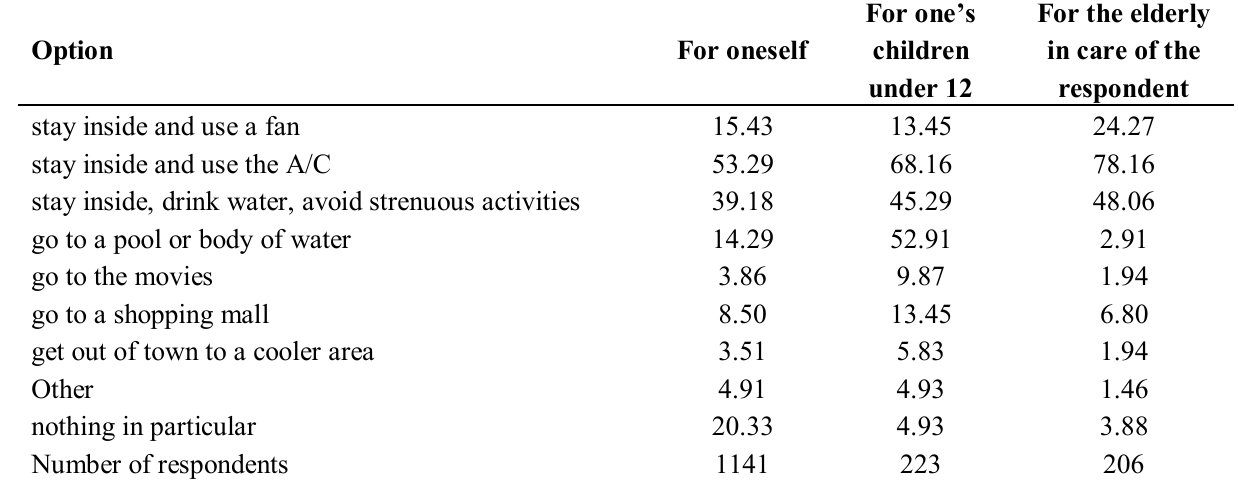
Table 15. Coping with a heat spell starting tomorrow. Percentage of the